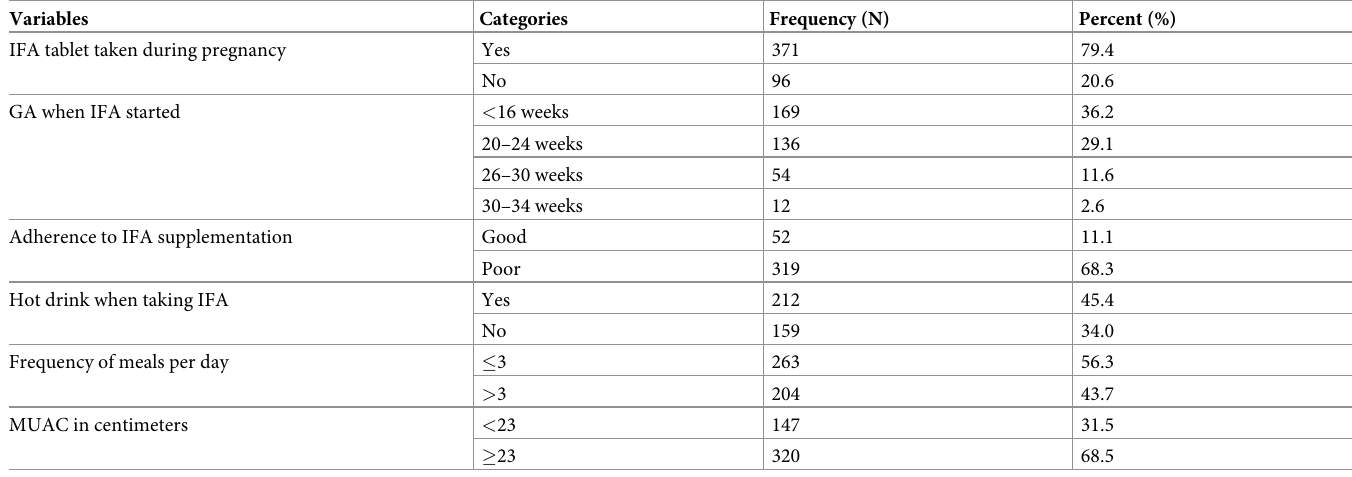
Table 3. Dietary and micronutrient uptake characteristics of immediate postpartum women in East Gojjam zone hospitals Northwest Ethiopia 2020 (n =